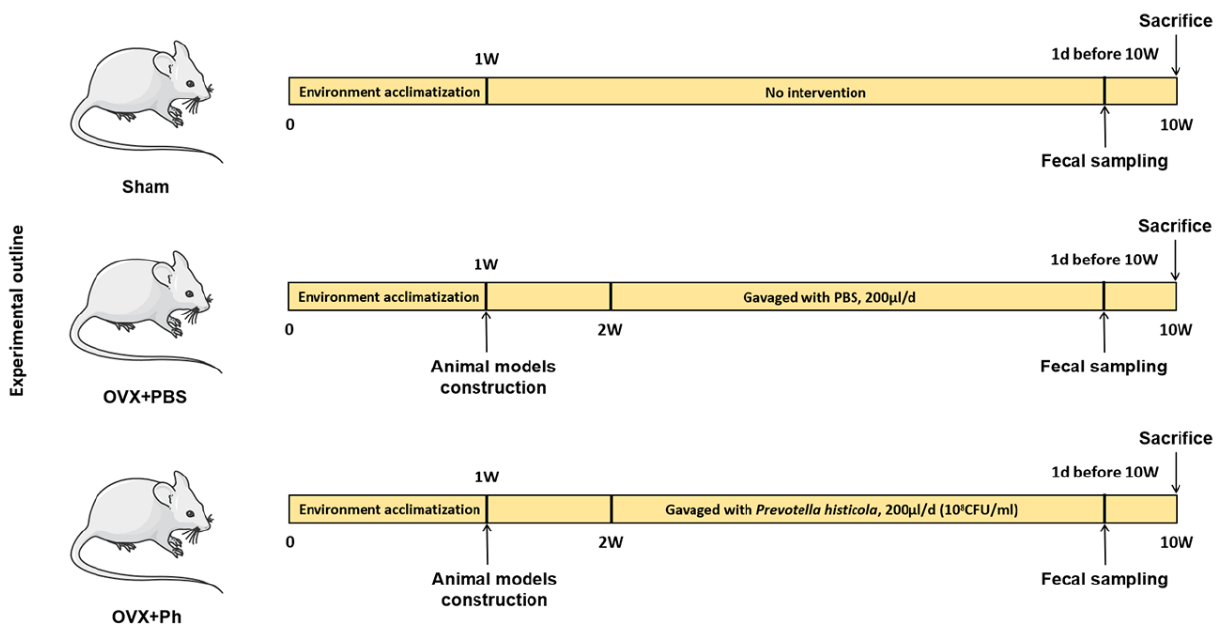
Figure 1. The whole experimental outline of this current study.